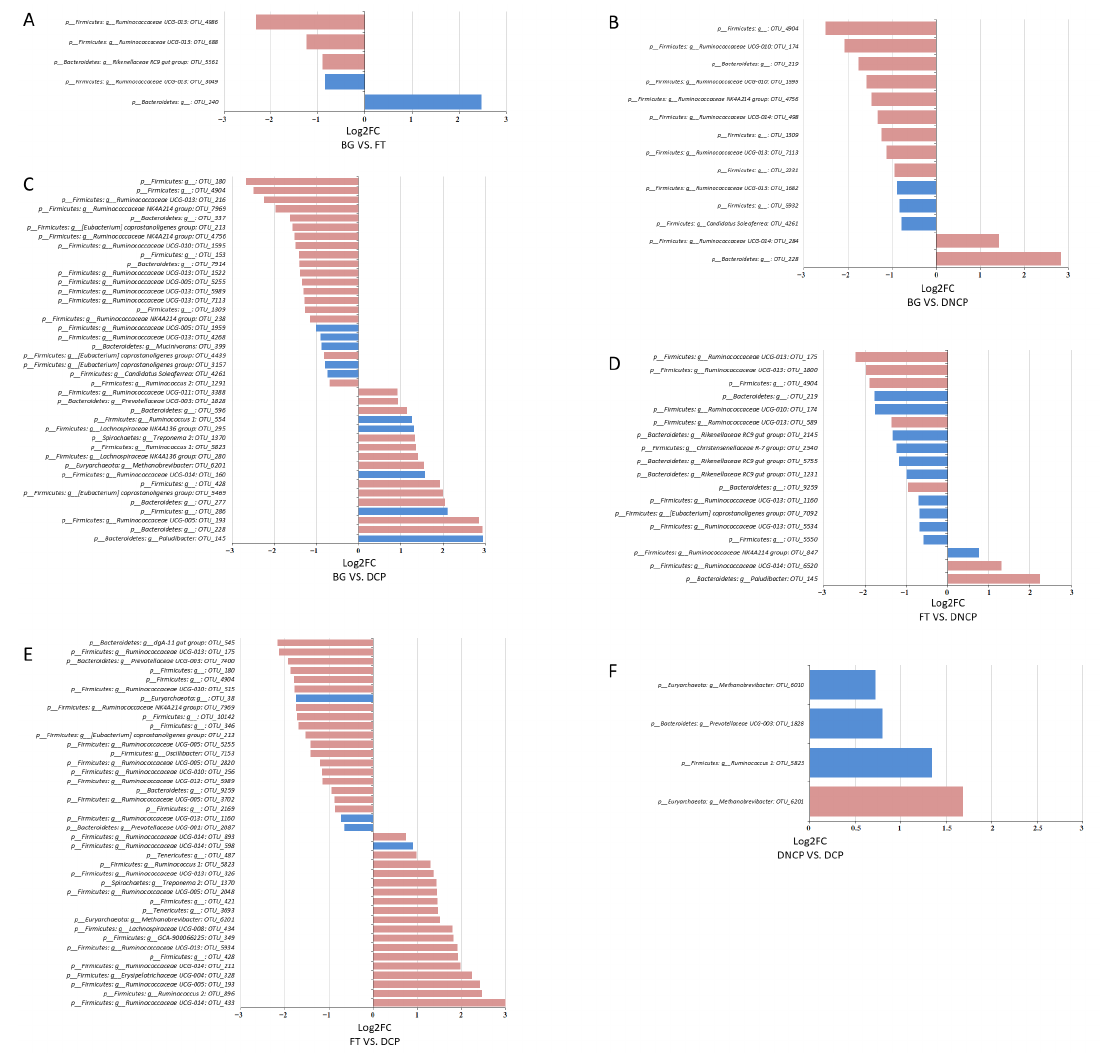
Figure 8. The differentially enriched OTUs among the four groups. Adjusted p < 0.05 ( blue ) or p < 0.01 ( red ) were considered significant. ( A )-BG VS. FT, ( B )-BG VS. DNCP, ( C )-BG VS. DCP, ( D )-FT VS. DNCP, ( E )-FT VS. DCP, ( F )-DNCP VS. DCP.